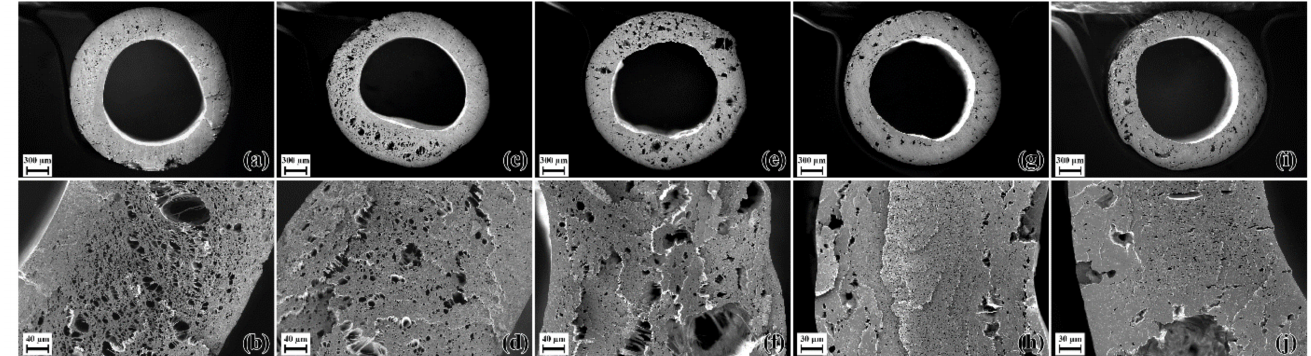
Figure 12. E3_PEG200_14 foams at various nozzle temperatures (T N ): ( a , b ) T N = 155 ◦ C; ( c , d ) T N = 160 ◦ C; ( e , f ) T N = 165 ◦ C; ( g , h ) T N = 170 ◦ C; ( i , j ) T N = 175 ◦ C. The images of the en-